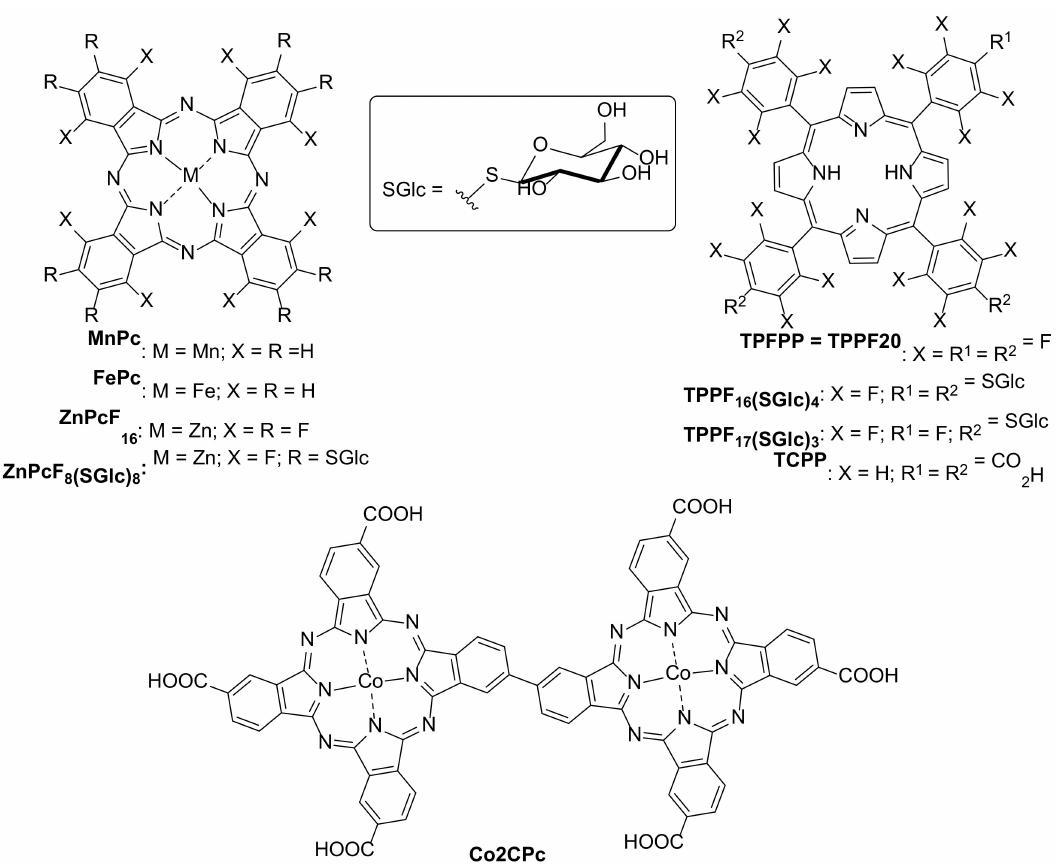
Figure 14. Structures of tetrapyrrolic macrocycles (TPM) used as catalysts for degradation of miscellaneous pharmaceuticals. Tom é [74] reported the preparation of hybrid catalysts TPPF 20 @MNP , TPPF 16 (SGlc) 4 @MNP , TPPF 17 (SGlc) 3 @MNP , ZnPcF 16 @MNP and ZnPcF 8 (SGlc) 8 @MNP via covalent linkage of meso -substituted porphyrins ( TPPF 20 , TPPF 16 (SGlc) 4 and TPPF 17 (SGlc) 3 , Figure 14) and phthalocyanines ( ZnPcF 16 and ZnPcF 8 (SGlc) 8 , Figure 14) to aminopropyl- functionalized silica-coated magnetic nanoparticles (MNP)(Table 7, entry 2). These cat- alysts were evaluated in the photodegradation of estradiol ( E2 , Figure 13), and the best results were obtained with TPPF 17 (SGlc) 3 @MNP and ZnPcF 8 (SGlc) 8 @MNP ),